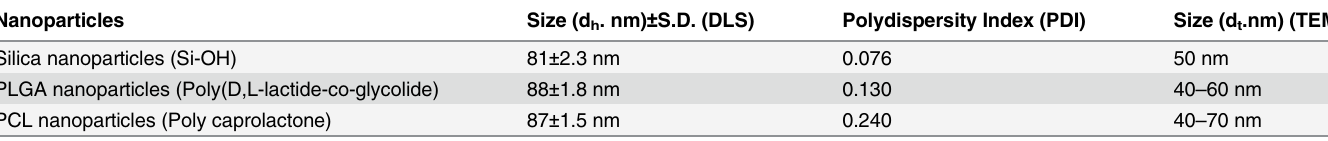
Table 1. Characteristics of different nanoparticles.